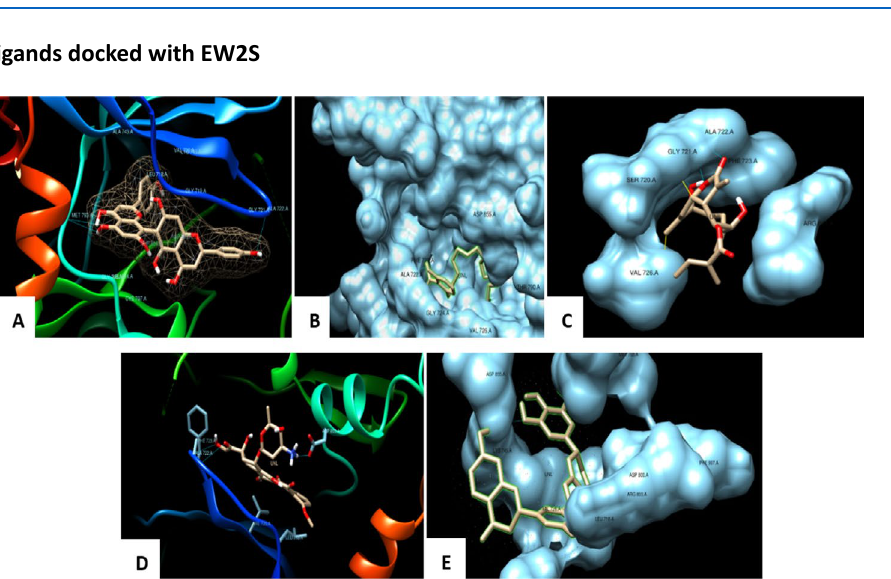
Fig. 5. Docked pose of the ligand shown with EGFR Kinase protein and the binding pocket of the EGFR protein fits the ligand by interactions and bonds A: Agasthisflavone, B: Anacardic acid, C: Zoapatanolide A, D: Doxorubicin and E: